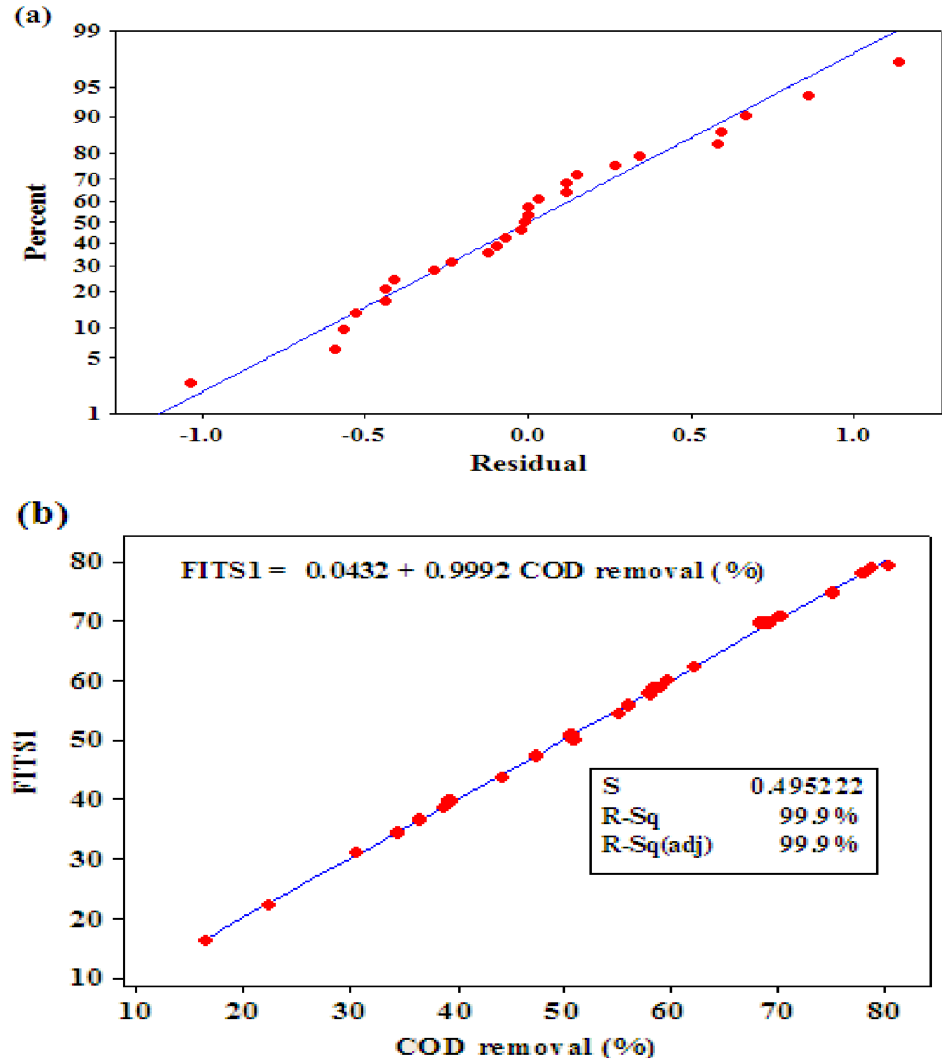
Figure 7. ( a ) the normal probability graph of residuals and ( b ) cross-plot of the experimental and predicted COD removal